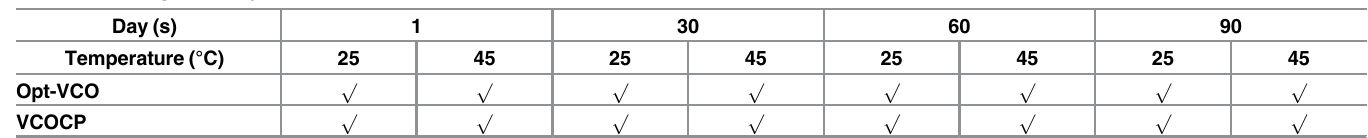
Table 10. Storage